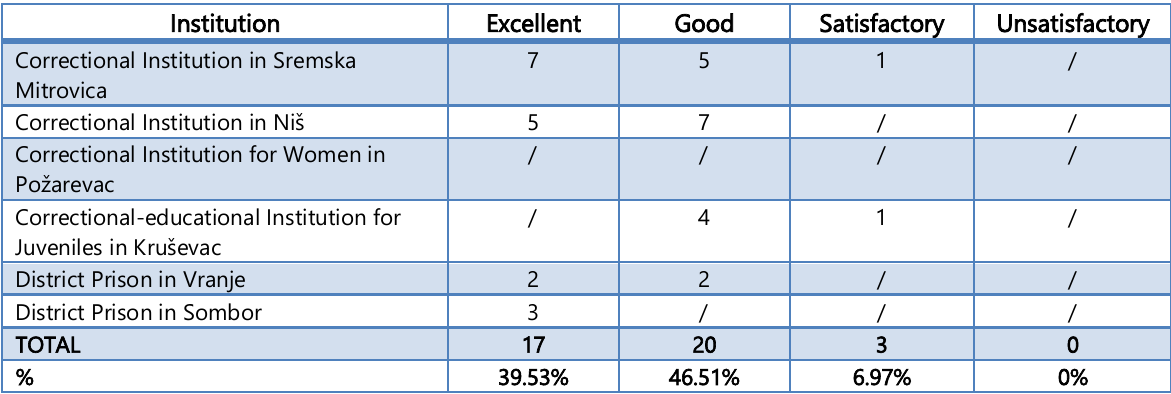
Table 10: How the Interviewed Persons Evaluate the Program in Which They Participated – Employees (Source: Author‟s